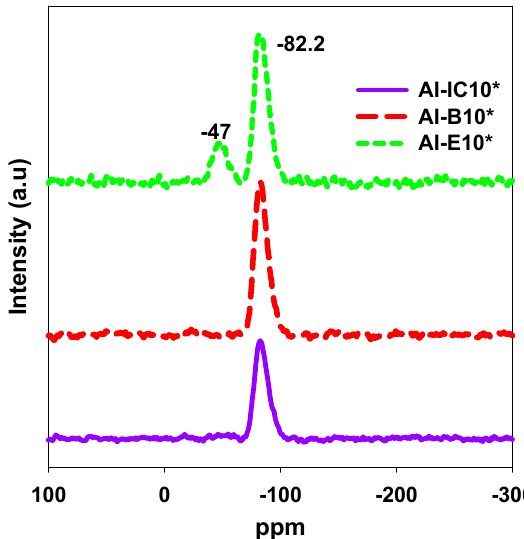
Materials 2018 , 11 , x FOR PEER REVIEW Figure 9. 1 H– 29 Si-MAS NMR spectra of the AI-IC10*, AI-B10*, and AI-E10* samples.